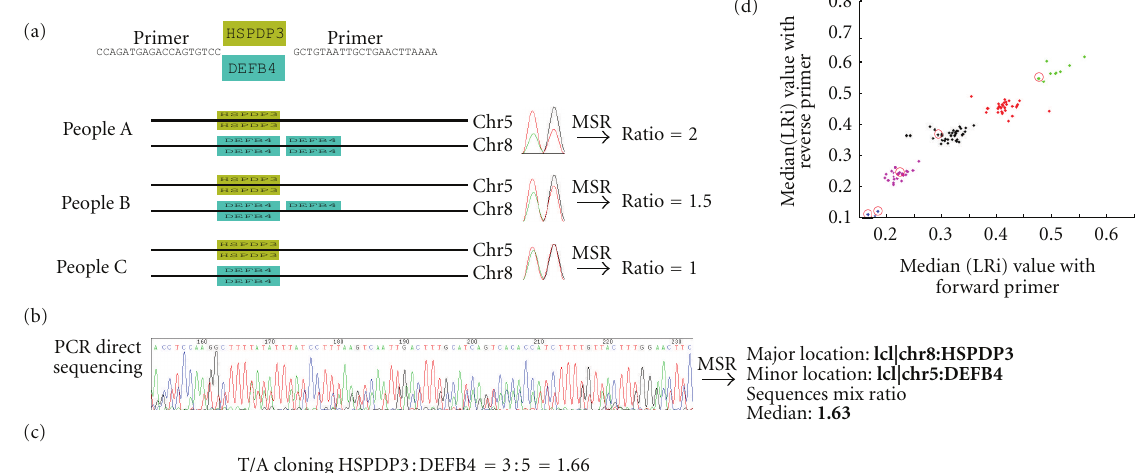
Figure 5: Experimental confirmation of HSPDP3 and DEFB4 copy numbers identified by Mixed Sequence Reader . (a) The primers used to amplify the DEF4B and HSPDP3 genes in the human genome. The LRi ratio between DEFB4 and HSPDP3 was calculated for each chroma- tography trace. The copy number of HSPDP3 is constant in the human genome ( n = 2). (b) The heterozygous chromatography trace of PCR products comprising both HSPDP3 and DEFB4 . The median DEFB4 / HSPDP3 ratio was 1.63, which was estimated by MSR program. (c) The PCR product from (b) was cloned, and at least twenty colonies were picked for DNA sequencing to calculate the ratio between DEFB4 and HSPDP3 . The observed ratio was 1.66, compatible with that derived from MSR. (d) Comparison of median LRi values from the forward and reverse primers. Using the k-means algorithm, pairs of median LRi values were clustered into 5 groups corresponding to di ff erent copy numbers (2, 3, 4, 5, and 6). Five samples (marked with circles) were cloned into the T and A vectors to validate the DEFB4 copy